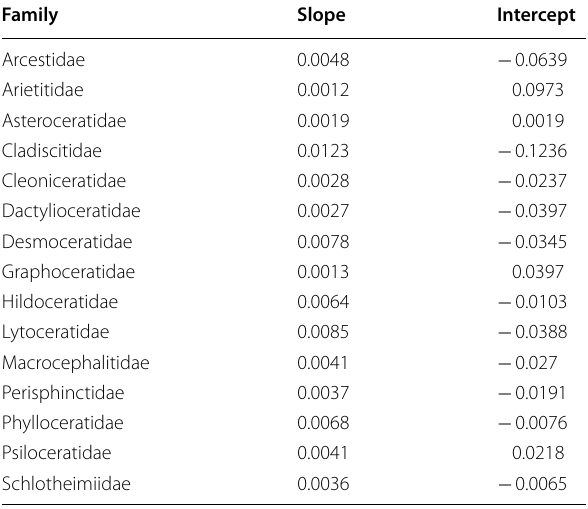
Table 5 Septal slope factor (short: slope) and intercept of Table 6 Septal slope factor (short: slope) and intercept of